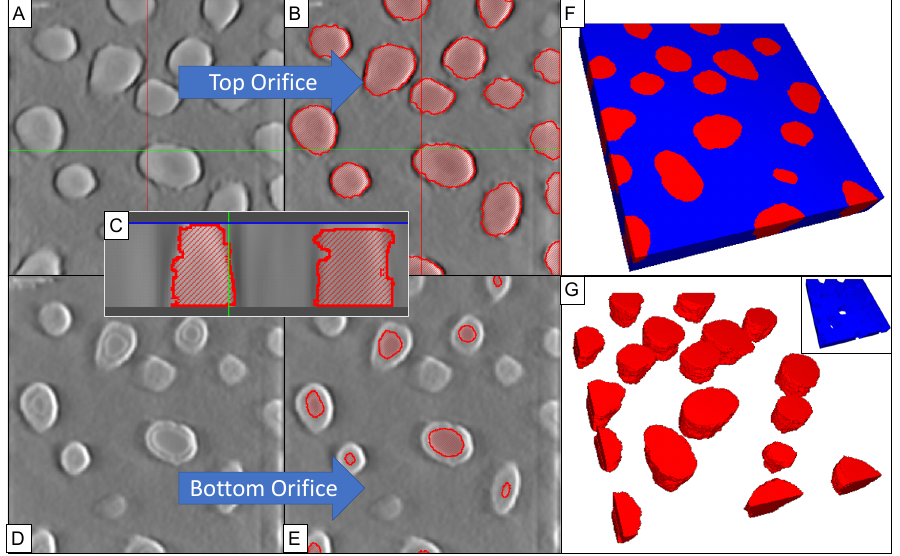
Figure 4. Method for Generating 3D models from Tilt Stacks. ( A ) As tomograms can be generated from the tilted images; ( B ) individual structures can be segmented at different layers within the stack by regions of similar intensity; ( C ) A cross section of the reconstruction highlights the nanopore walls; ( D ) Reconstructed layers can merge the bottom orifice with a thinly floored pore due to similar intensities; ( E ) requiring manual adjustment to the narrowest orifice; ( F ) Segmented nanopores in a volume stack, viewed on the largest orifice; ( G ) Reconstructed nanopores (red) or the nanomembrane (blue inset, inverse of G) can then be exported into other software for visualization or simulation purposes.